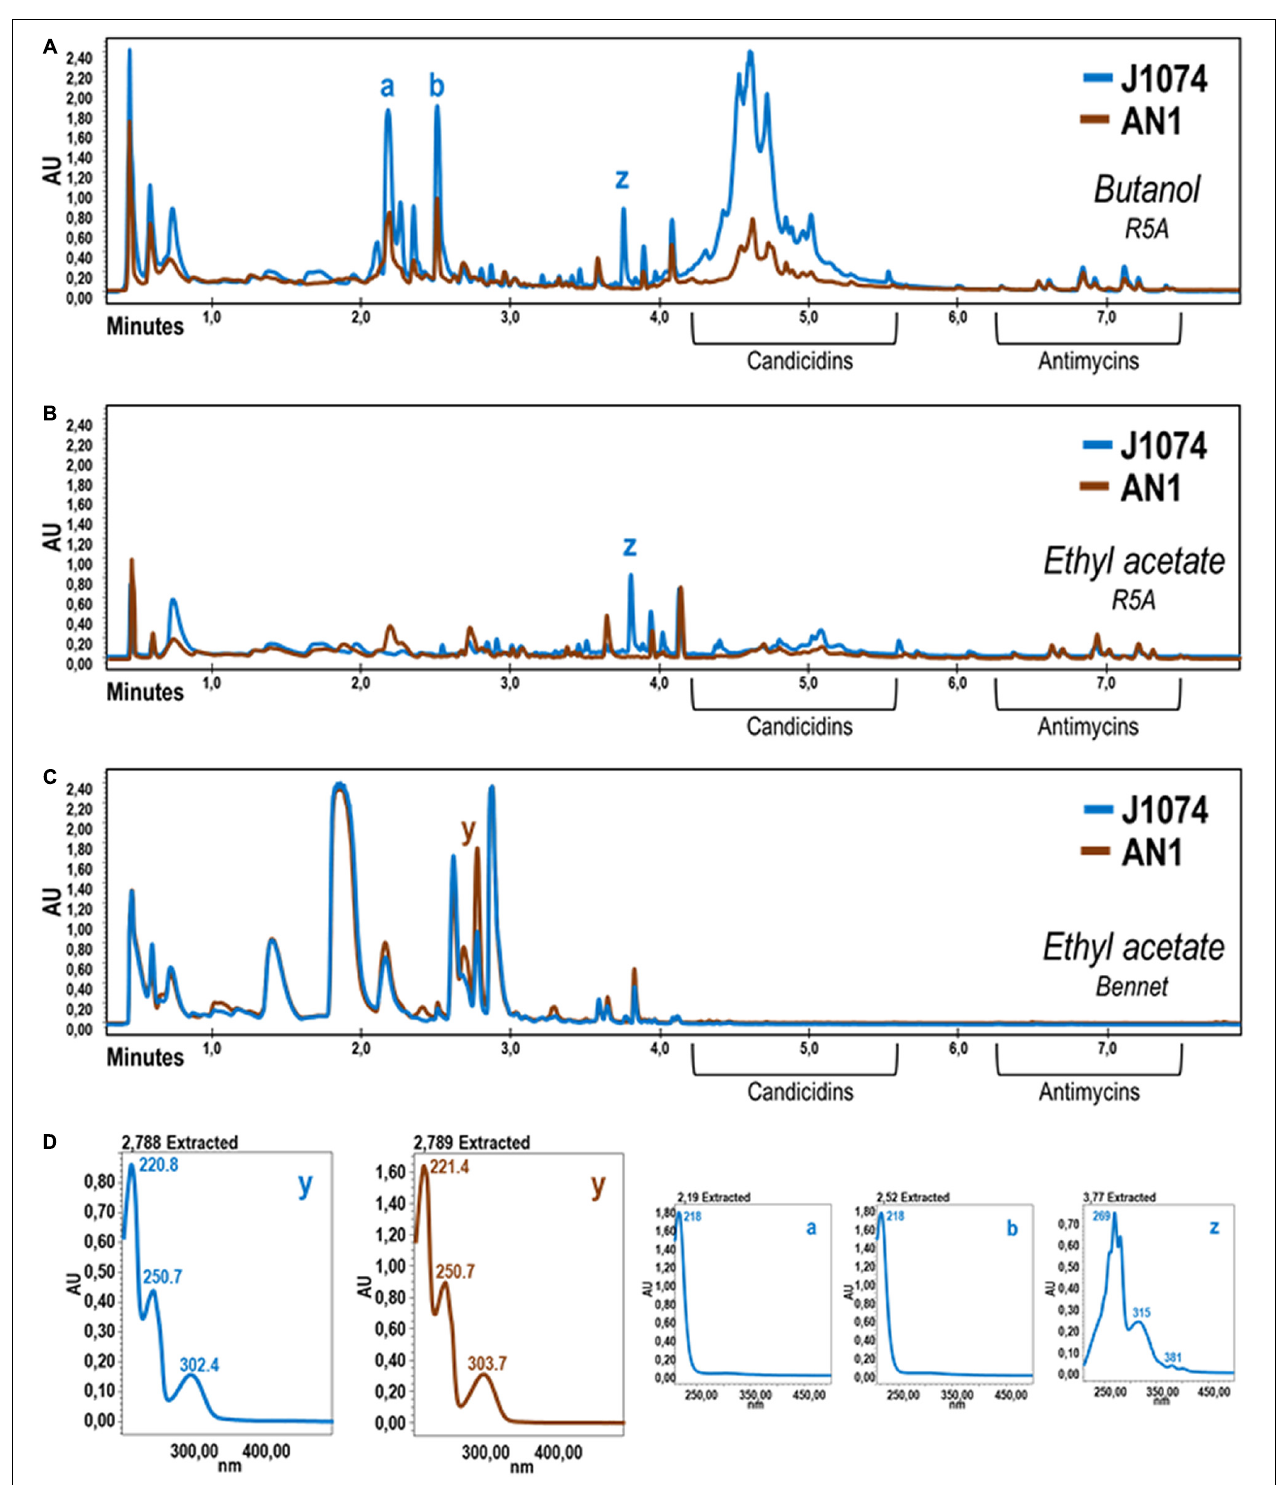
FIGURE 3 | Comparative UPLC chromatograms of cell extracts obtained with several solvents using cultures of S. albus AN1 (brown) and J1074 (blue) in different broths. The two strains were grown in R5A (A,B) or Bennet (C) broth for 96 h and their corresponding metabolites extracted with either 1-butanol (A) or ethyl acetate (B,C) . Note that, when both strains are grown in R5A, the candicidins are hardly detected with the ethyl acetate extraction procedure. (D) UV spectra of differential peaks (a, b, y, and z) are shown. UV spectra of peaks a-b and those in between (not shown) were almost identical. These molecules were unable to be dereplicated and therefore no specific activity could be attributed to these putatively unknown